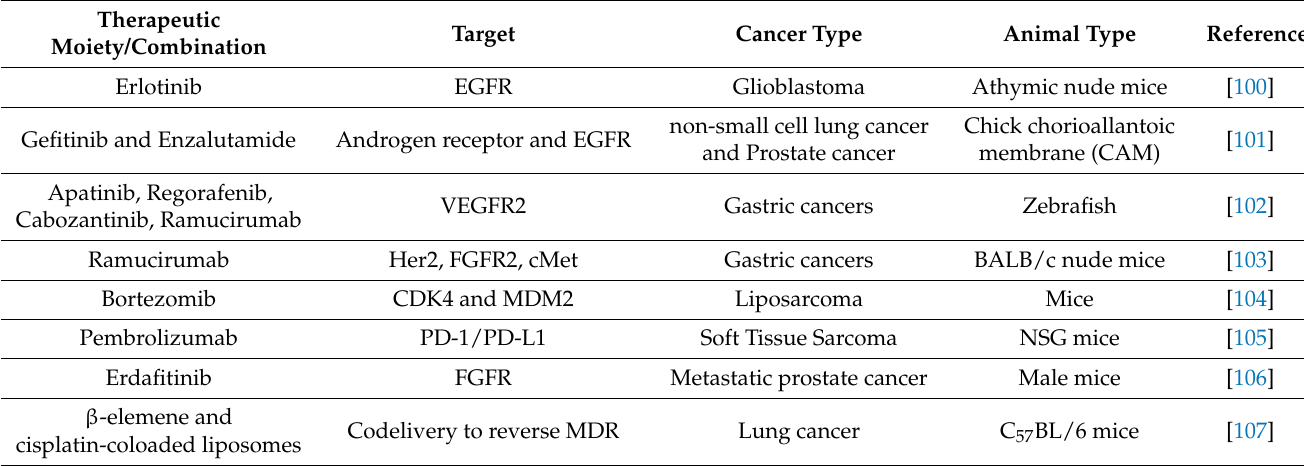
Table 2. Recent progress and status of patient-derived tumor